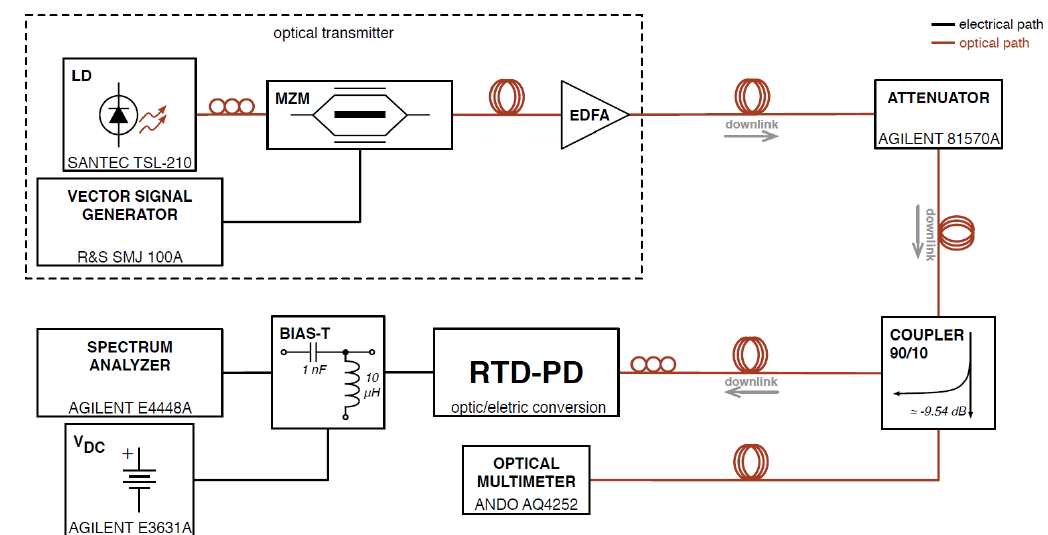
Figure 10. Description of the downlink experimental